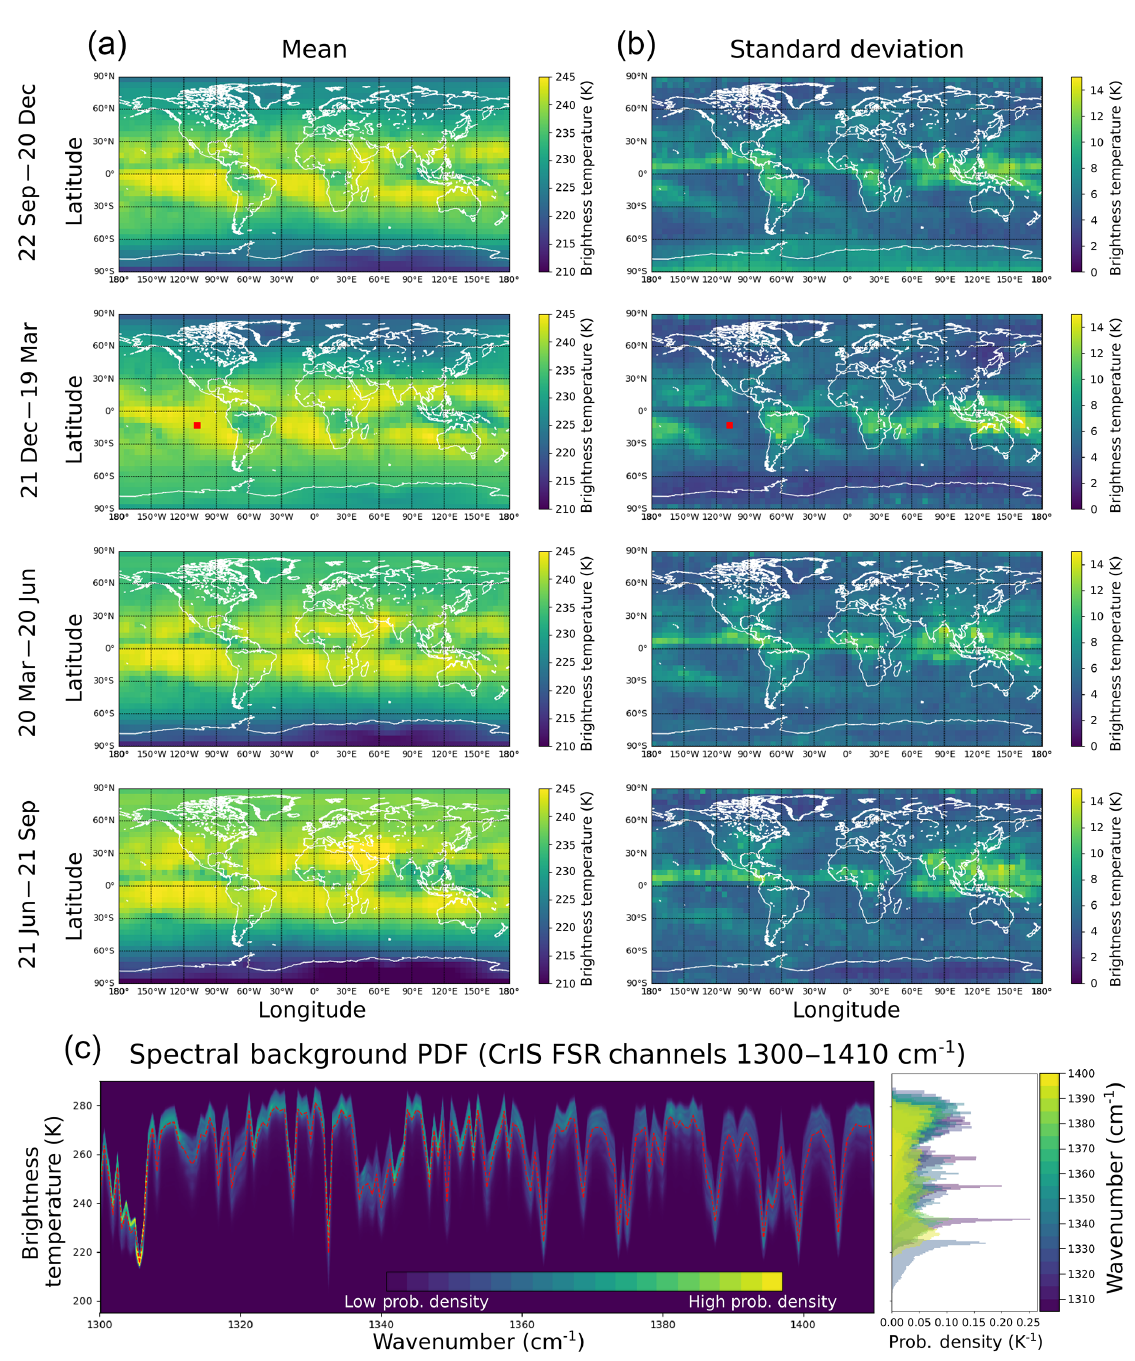
Figure 4. SNPP CrIS mean (a) and standard deviation (b) brightness temperature at 1300cm − 1 for each grid cell and each season interval. The red dot corresponds to the data shown in panel (c) . (c) Marginal PDF of the background spectrum indicated by the red dot in panels (a) and (b) with mean spectrum (red dashes) and several individual marginal PDFs (right)